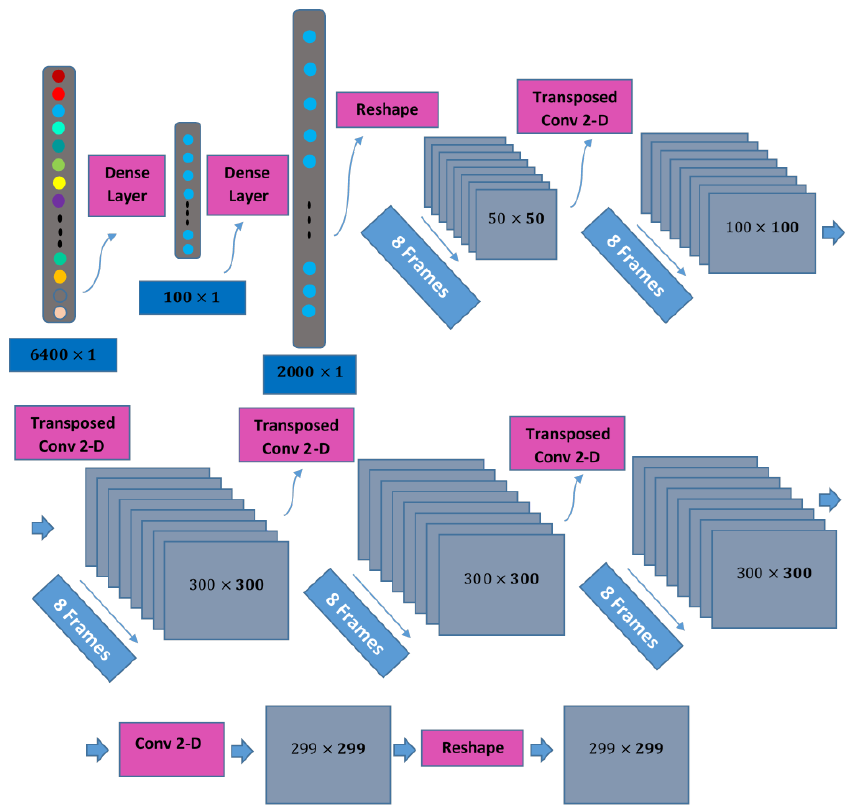
Figure 6. Dimensions of different layers of generator part of the proposed